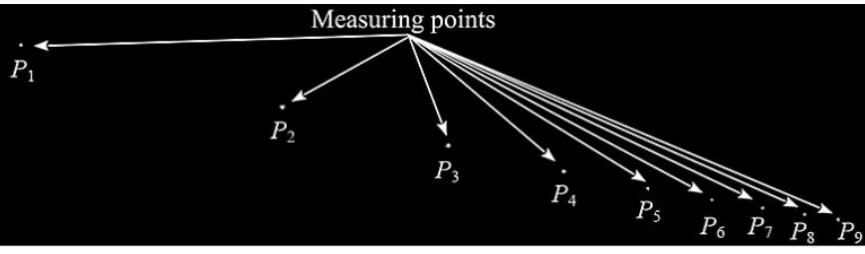
Figure 11. Selected image from the camera.